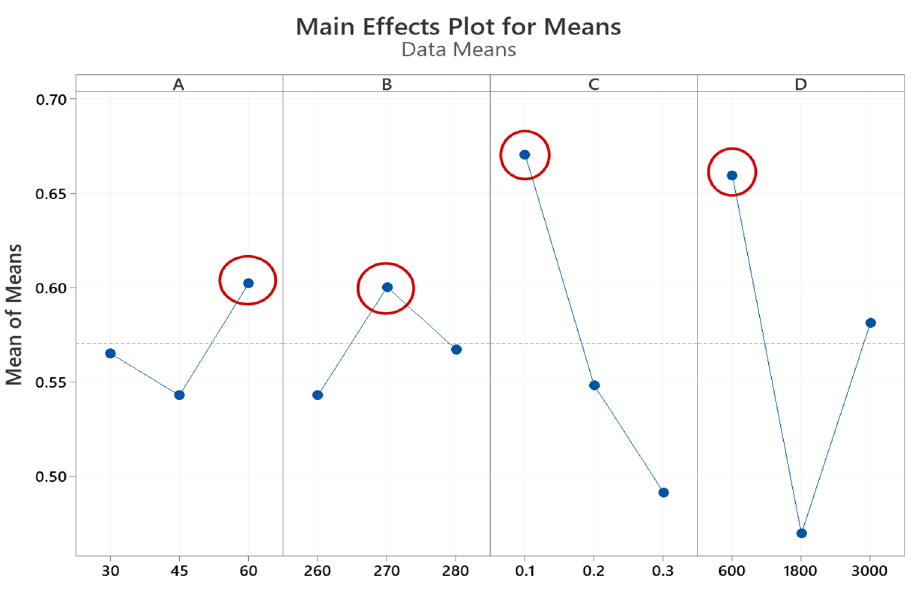
Figure 8. Main Effects Plot for means